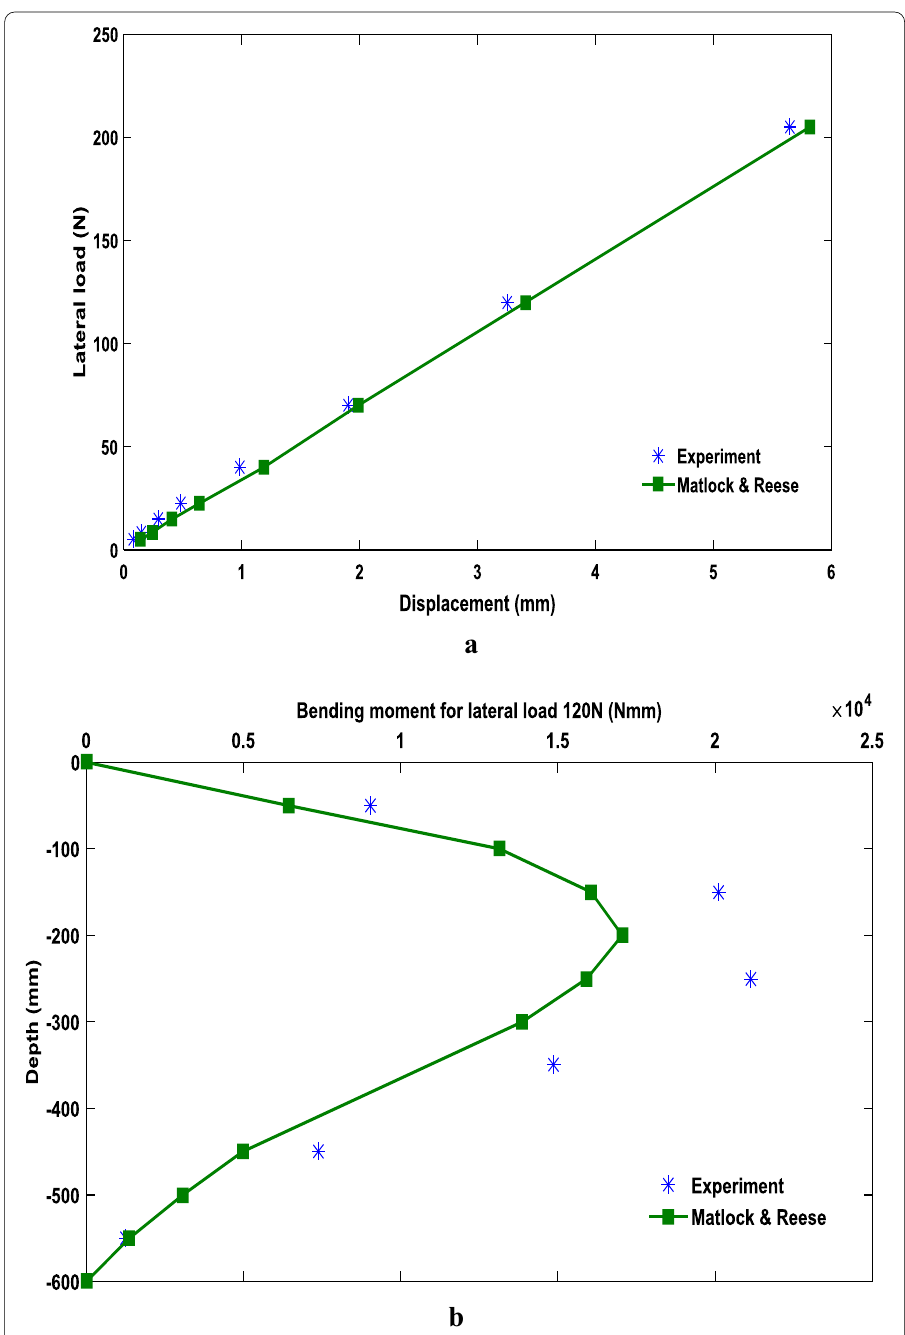
Fig. 9 a. Displacement of pile in horizontal ground . b. Bending moment of pile in horizontal